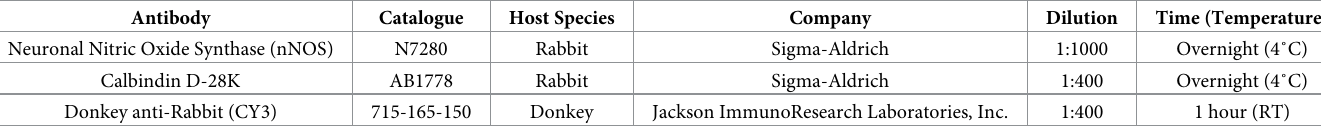
Table 2. Antibody reagent list. Both primary and secondary antibodies were diluted in 1% NDS and 0.5% Triton-x in PBS. RT, room